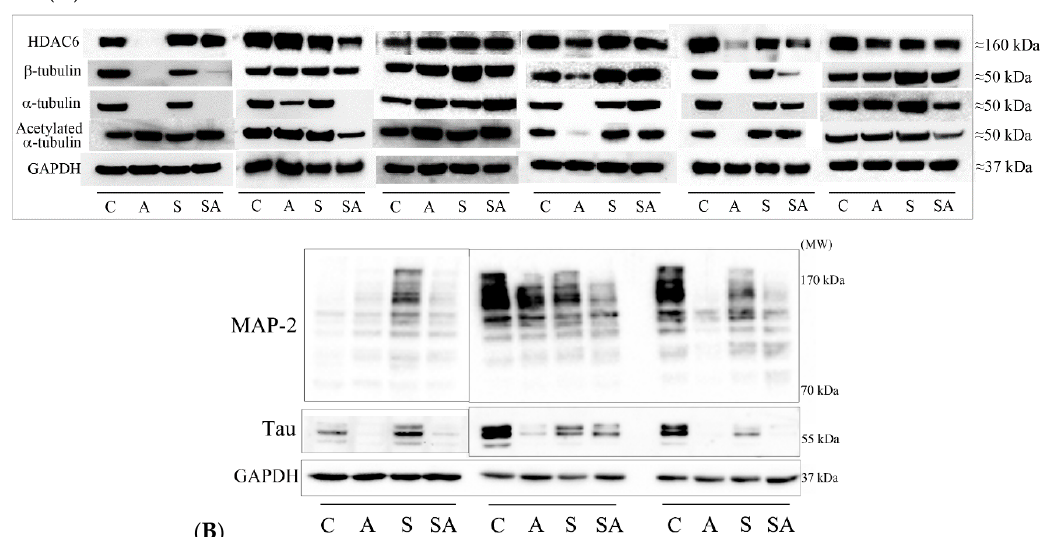
Figure 2. Protein levels of PFC proteins visualized by Western blotting. ( A ) Cytosolic proteins resolved by one dimensional polyacrylamide gel electrophoresis (1D PAGE) were Western blotted using antibodies to HDAC6, β -tubulin, α -tubulin, acetylated α -tubulin, and GAPDH. Blotting panels from six sets of matched control (C), alcoholic (A), suicide (S), and suicide alcoholic (SA) patients are included. ( B ) Cytosolic proteins resolved by 1D PAGE were Western blotted with antibodies to MAP-2, MAP-tau, and GAPDH. Blotting panels from three sample sets of matched control (C), alcoholic (A), suicide (S), and suicide alcoholic (SA) patients are included.